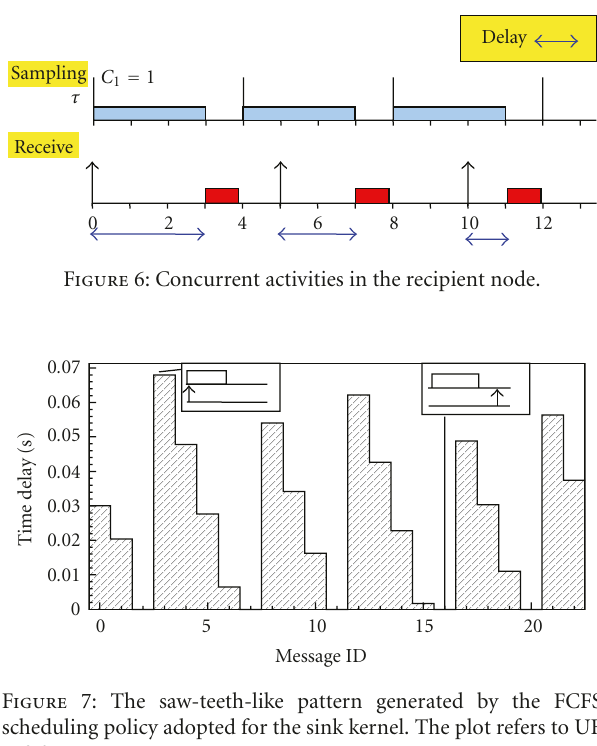
the load task later and later thus being delayed less and less. In Figure 7, adopting a non-preemptive scheduling policy, the packet reception delay is plotted against a progressive